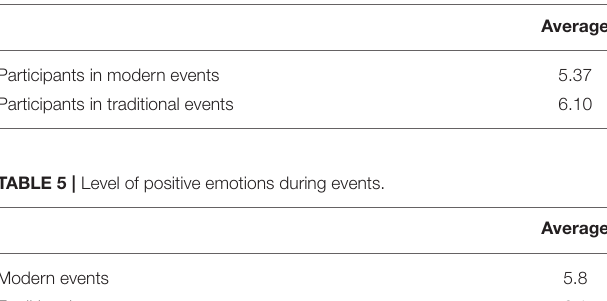
TABLE 4 | Desire to participate in the same event again.